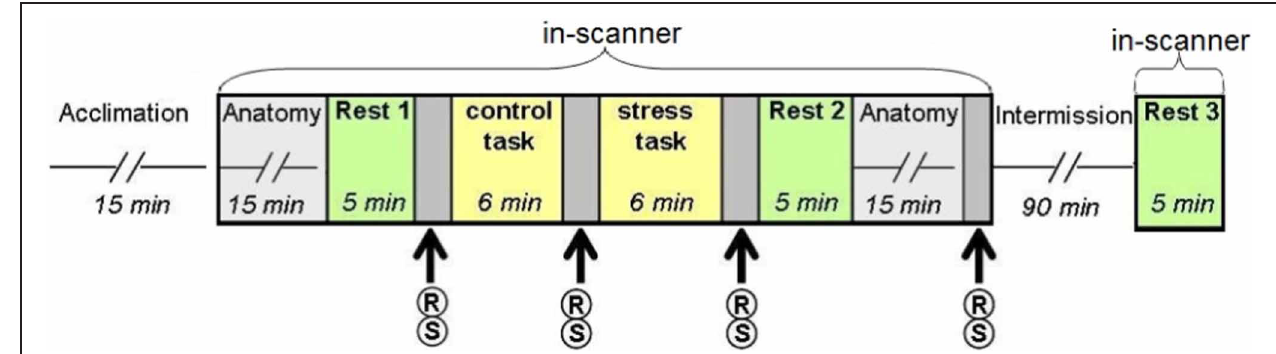
FIGURE 1 | Study design. Following the acclimation phase, participants underwent two scanning sessions: the first included two “rest” conditions interspersed with the control (backward counting) and stress (serial